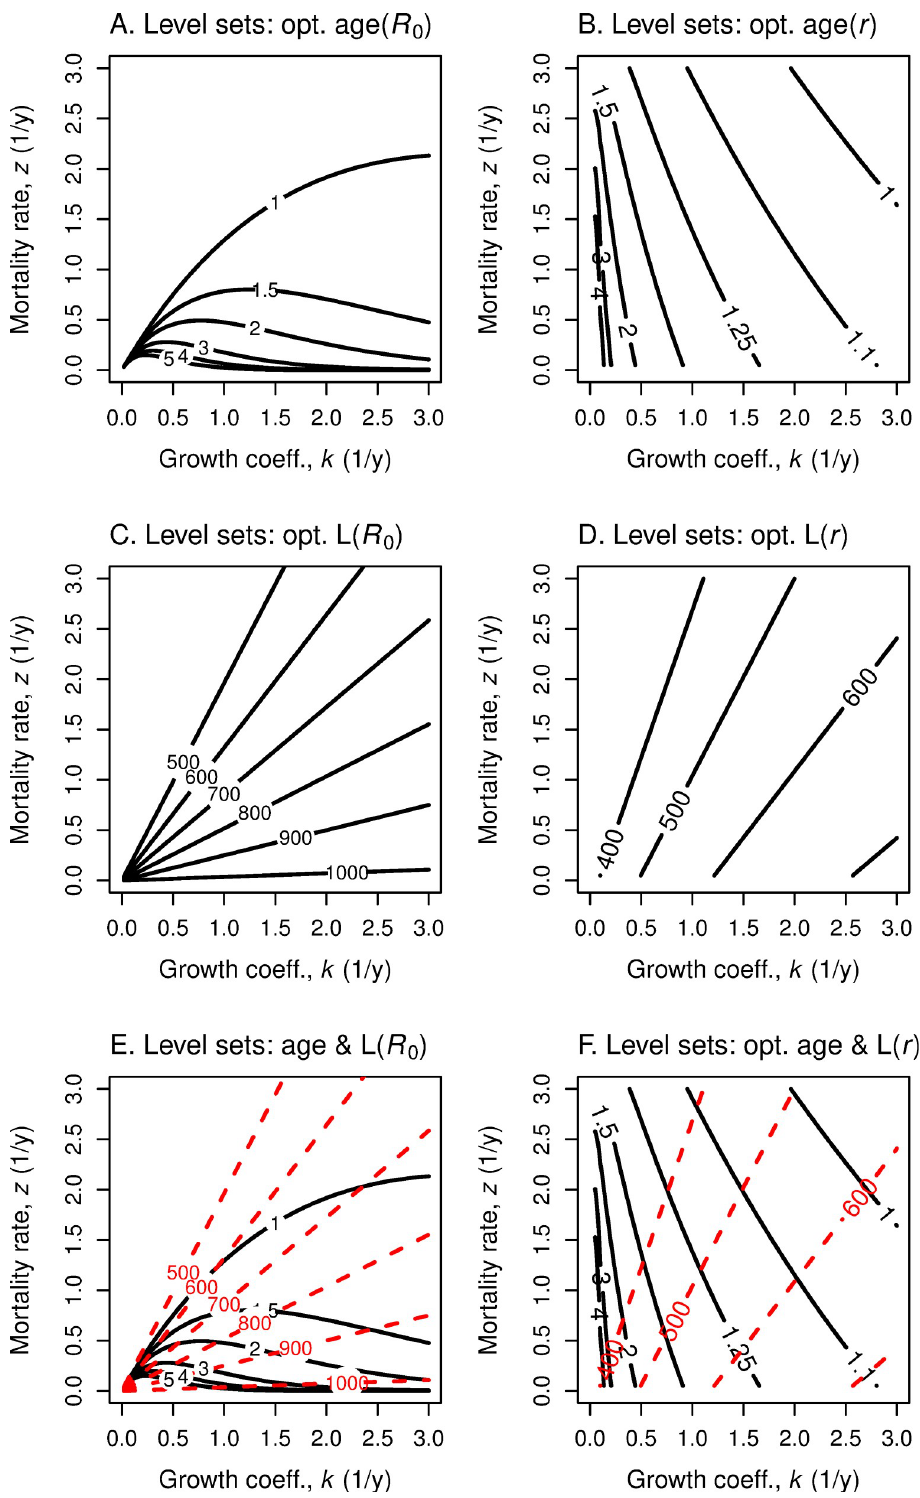
Fig 12. Level sets of optimal age and length as functions of growth rate and mortality rate. These panels repeat the analyses in Fig 11 but use von Bertalanffy growth.